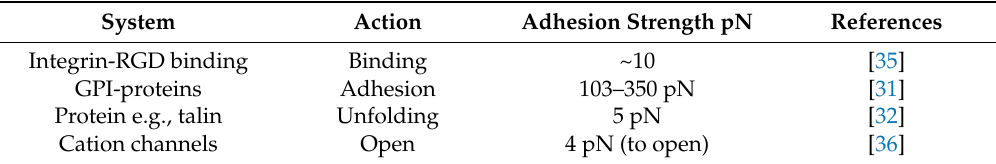
Table 1. Piconewton forces crucial to biochemical function and Hechtian adhesion.